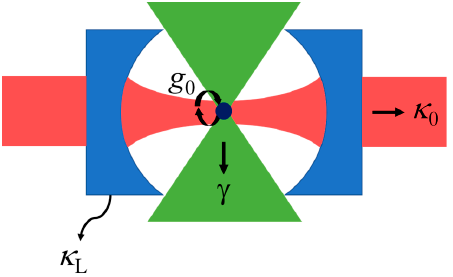
Figure 4. Schematic representation of a CQED system encompassing a single atom inside an